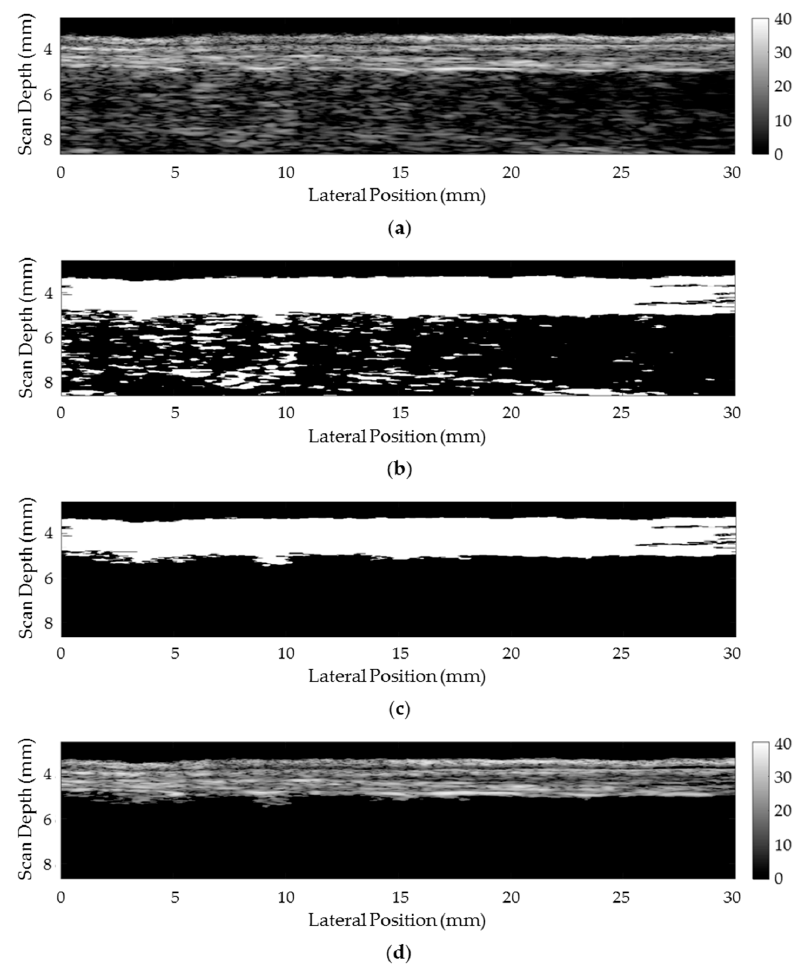
Figure 2. Sequencing for the digital segmentation of the heterogeneous tissue samples to isolate the mucosa/submucosa. All images are shown with the superficial layer towards the top of the image. ( a ) Original ultrasound image ( b ) Initial threshold mask ( c ) Processed mask ( d ) segmented image.